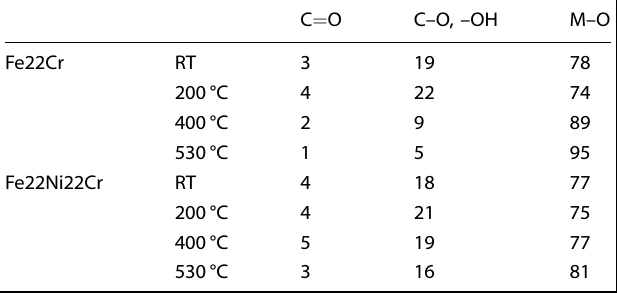
Table 1. O 1s peak fi tting results (% area) for samples exposed to high purity (99.999%) CO 2 .